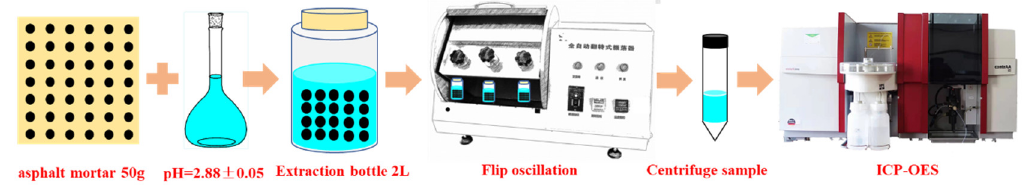
Figure 6. Procedures of TCLP.